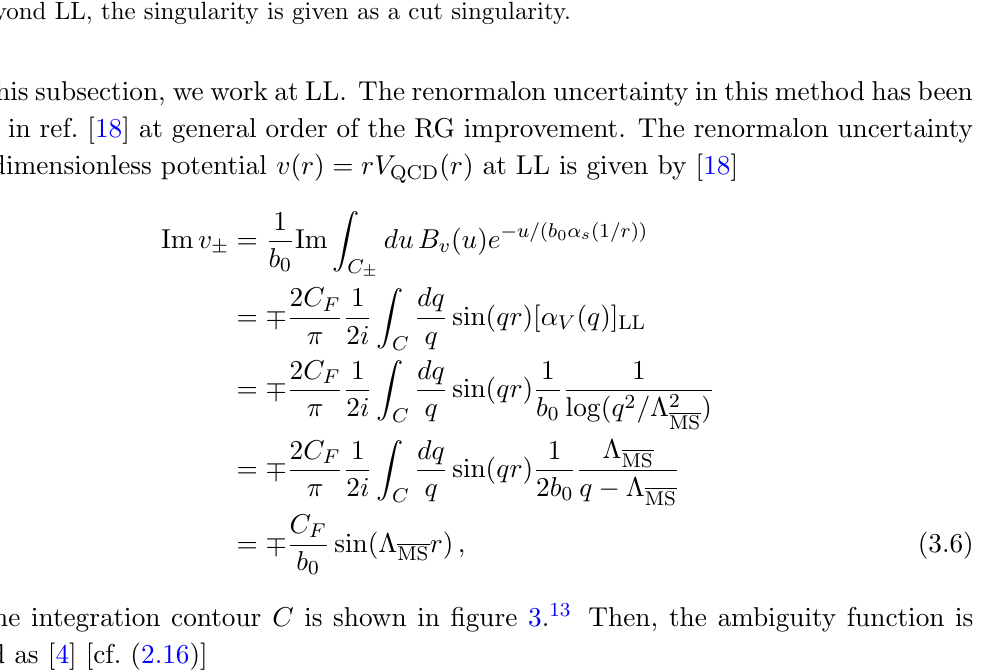
Figure 3 . Contour C . q (cid:3) represents a singularity of the running coupling. At LL, it is a simple pole. Beyond LL, the singularity is given as a cut